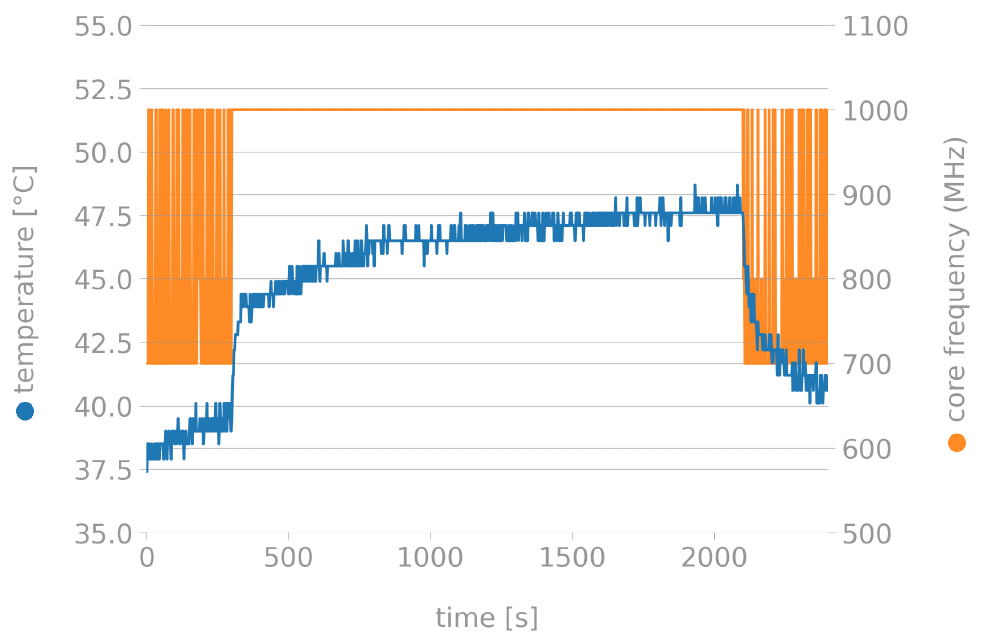
Figure 5. Localization module stress test